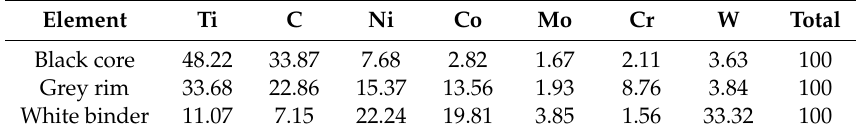
Figure 8. EDS point scanning results: ( a ) black core; ( b ) grey rim; ( c ) white binder. Table 6. EDS of Ti(C,N)-based cermets (wt.%).